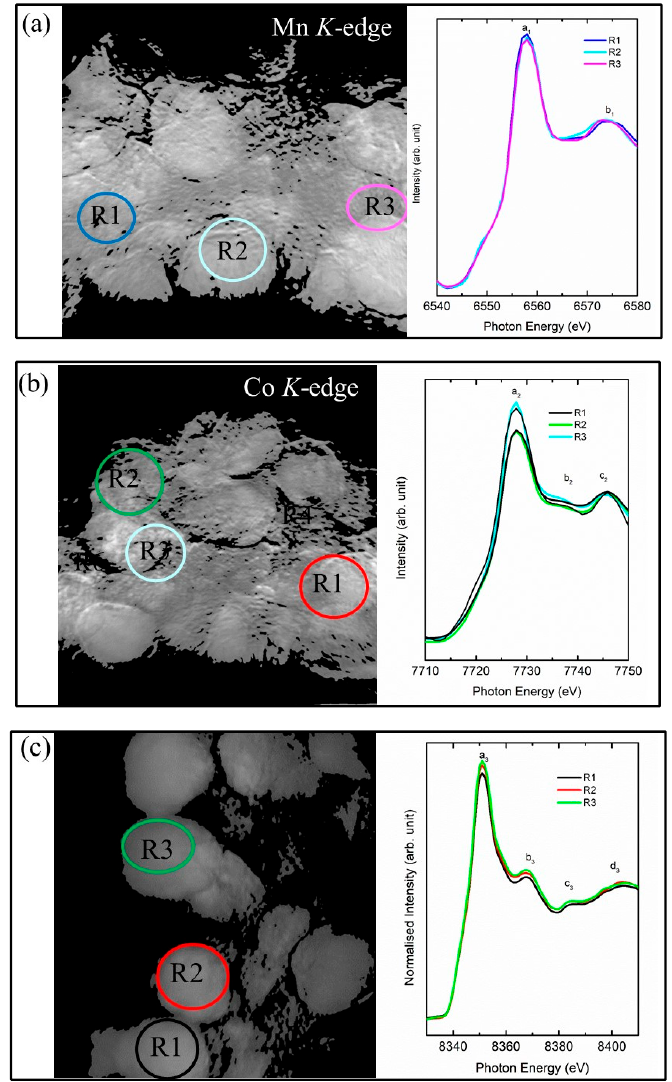
Figure 3. ( a ) Mn K -, ( b ) Co K -, and ( c ) Ni K -edge XANES spectra extracted from each region of interest (ROI), R 1 , R 2 , and R 3 , equivalent to the dimensions of secondary